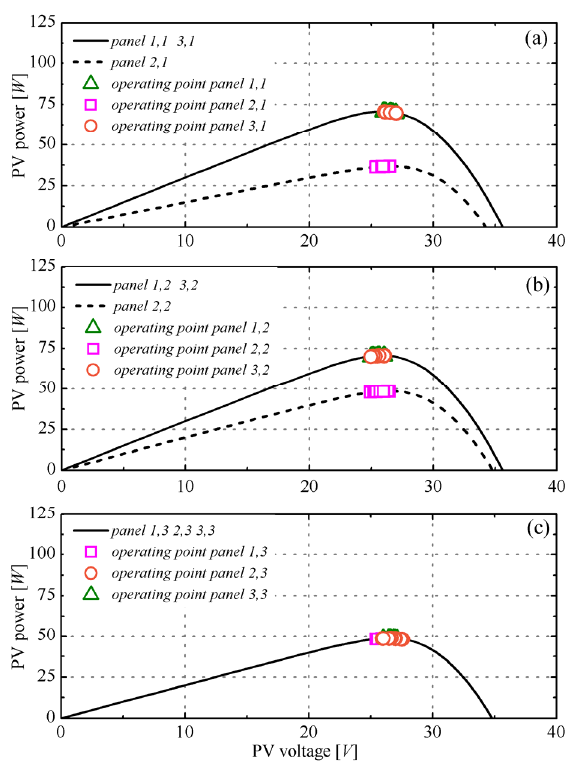
Figure 8. Partial shading: the operating point position corresponding to three panels in the p -th phase leg (namely, panel 1, p (pink squares), panel 2, p (orange circles), and panel 3, p (green triangles)) is highlighted with respect to the individual panel P–V curves. The solid-line P–V curves correspond to the panels under sunny conditions, while the dashed lines describe panels 2, 1 and 2, 2 under partial shading conditions. ( a ) Phase leg 1; ( b ) phase leg 2; ( c ) phase leg 3.